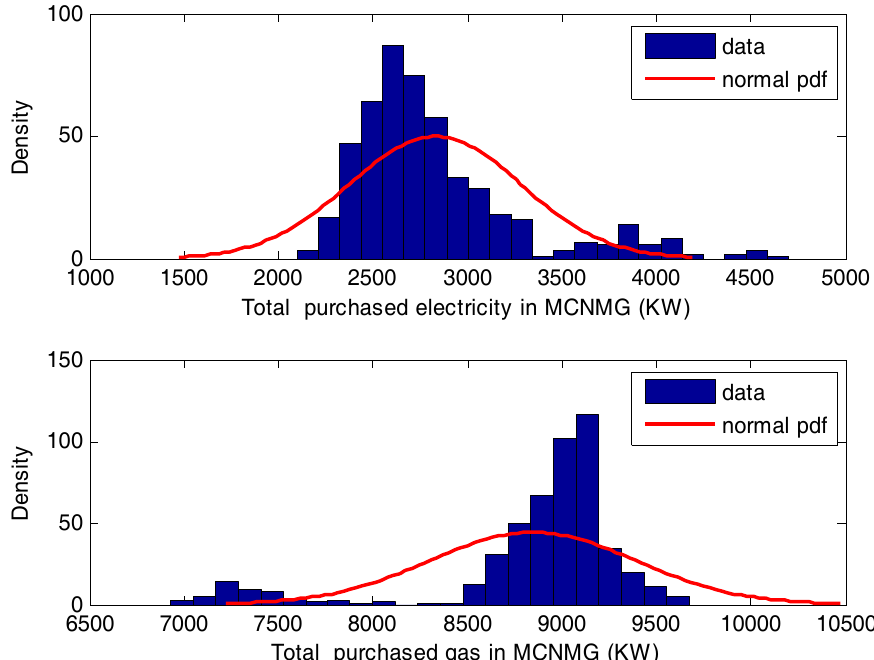
Figure 6. PDF of the total purchased energy in MCNMG. Top: Electricity; Bottom: Natural gas.